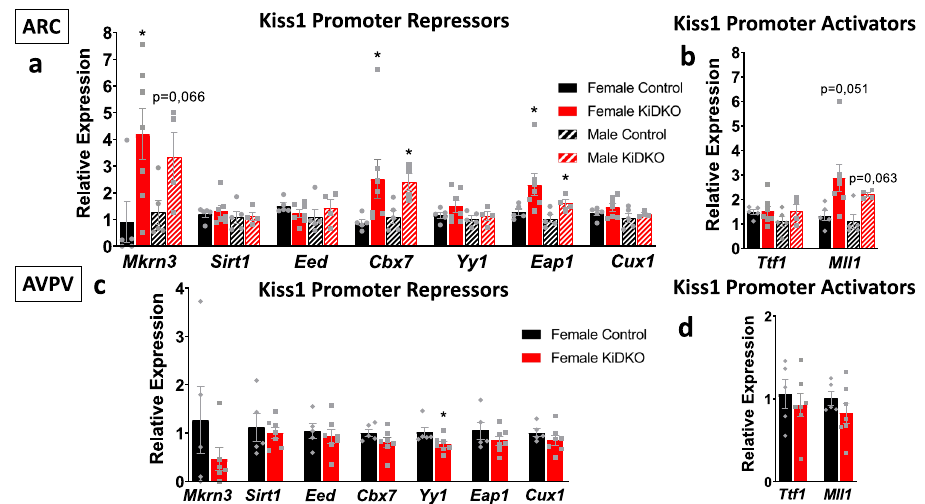
Fig. 7 | Molecular mechanismsunderlying Kiss1 neuronal alterations in KiDKO mice. Relative expression of Kiss1 promoter repressors, Mkrn3, Sirt1, Eap1, Cux1, and members of the Polycomb group, Eed, Cbx7, and Yy1, were analyzed in ARC Kiss1 neurons isolated by FACS from control and KiDKO male and female mice ( a ) and in AVPV Kiss1 neurons from control and KiDKO female mice ( c ). In addition,